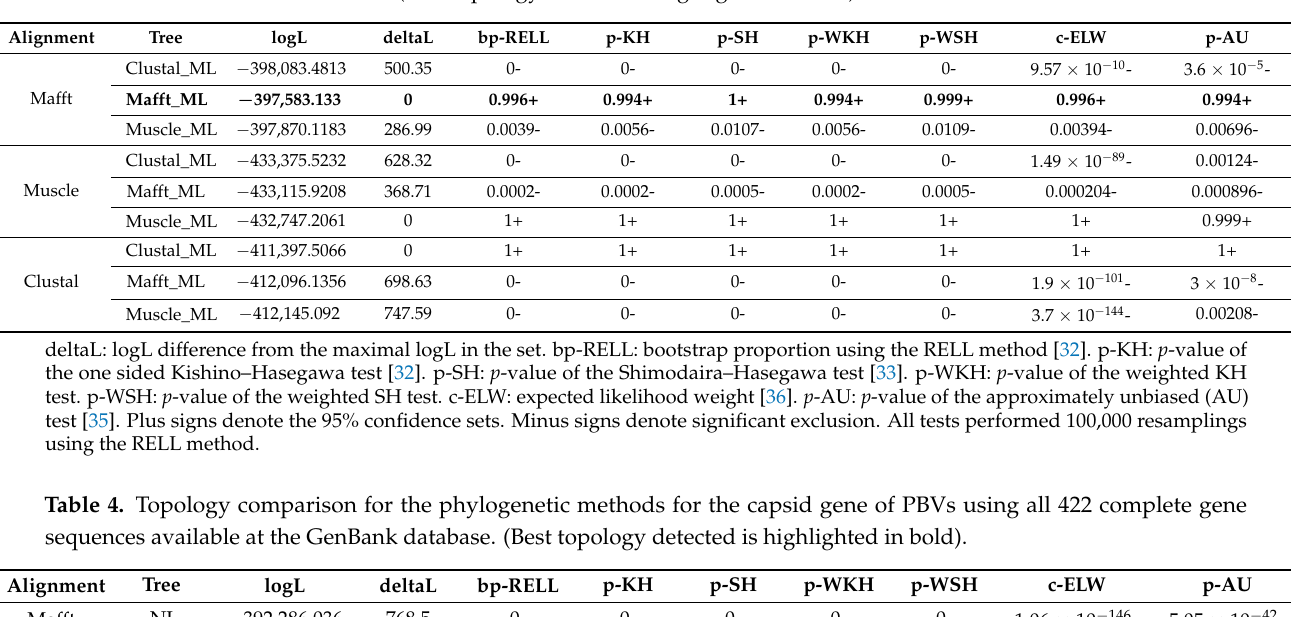
Table 3. Topology comparison for phylogenetic methods for the capsid gene of PBVs using all 422 complete gene sequences available at the GenBank database. (Best topology detected is highlighted in bold).